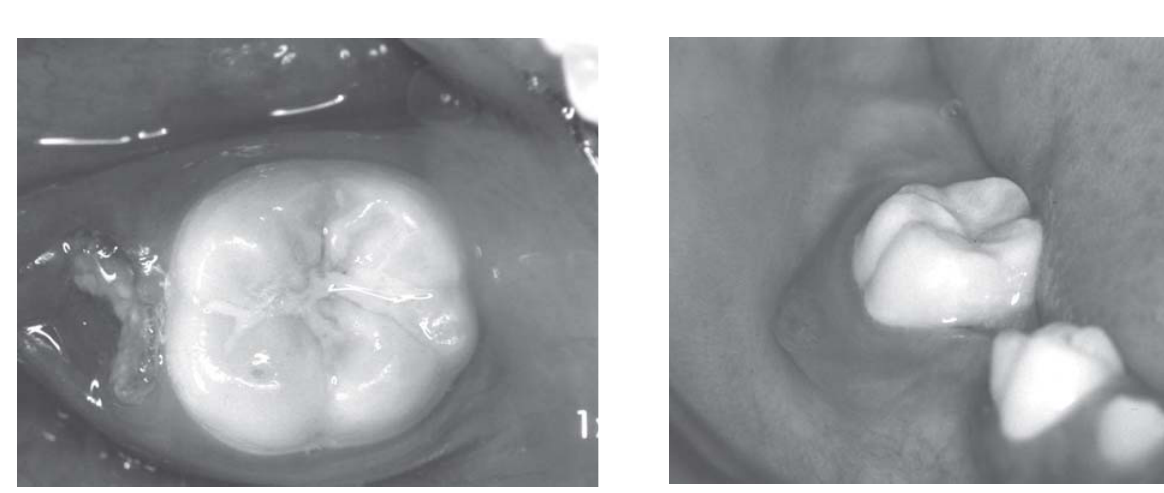
Figure 8- Small cavity entrance, filled at